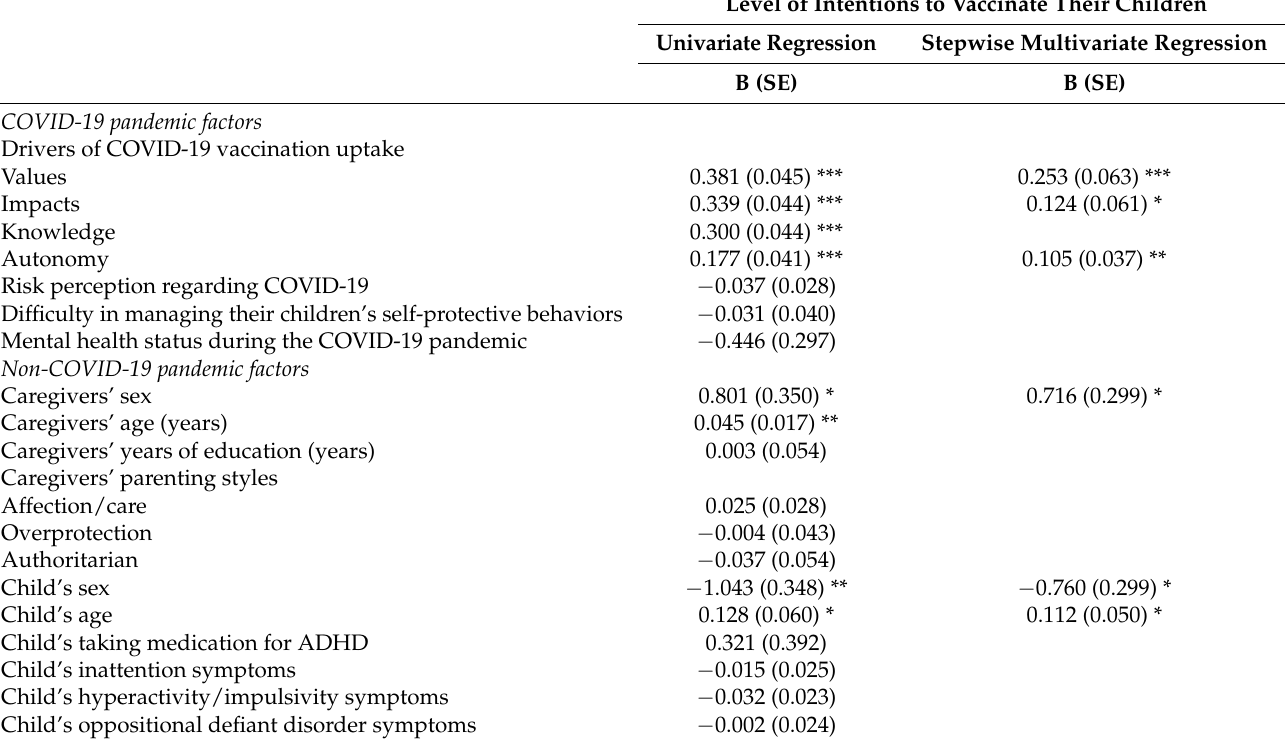
Table 2. The association between the COVID-19 pandemic and non-COVID-19 pandemic factors related to the level of caregivers’ intentions to vaccinate their children with ADHD against COVID-19: univariate and stepwise multivariate regression